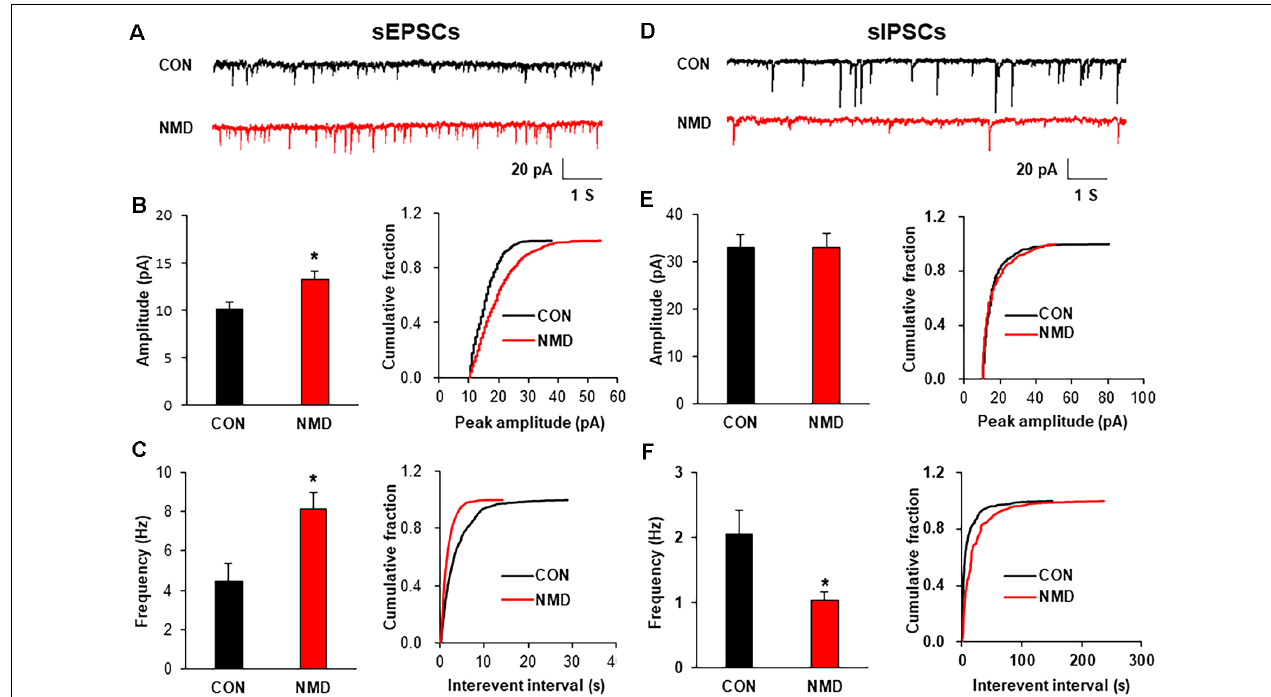
FIGURE 2 | NMD enhanced spinal sEPSCs and reduced sIPSCs. (A) Representative traces of sEPSCs recorded in the spinal dorsal horn neurons of CON and NMD rats at T13-L2. (B) Bar plots and cumulative probability distributions of the amplitude of sEPSCs recorded in the spinal dorsal horn neurons of CON and NMD rats at T13-L2 (* P < 0.05, n = 9 cells for CON and n = 18 cells for NMD, two-sample t -test). (C) Bar plots and cumulative probability distributions of the frequency of sEPSCs recorded in the spinal dorsal horn neurons of CON and NMD rats at T13-L2 (* P < 0.05, n = 9 cells for CON and n = 18 cells for NMD, two-sample t -test). (D) Representative traces of sIPSCs recorded in the spinal dorsal horn neurons of CON and NMD rats at T13-L2. (E) Bar plots and cumulative probability distributions of the amplitude of sIPSCs recorded in the spinal dorsal horn neurons of CON and NMD rats at T13-L2 ( P > 0.05, n = 7 cells for CON and n = 8 cells for NMD, two-sample t -test). (F) Bar plots and cumulative probability distributions of the frequency of sIPSCs recorded in the spinal dorsal horn neurons of CON and NMD rats at T13-L2 (* P < 0.05, n = 7 cells for CON and n = 8 cells for NMD, two-sample t -test).